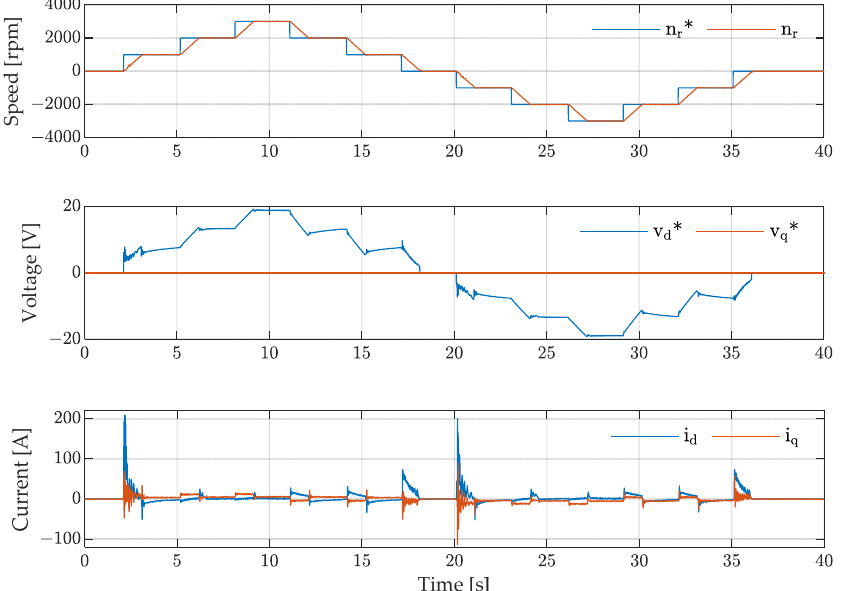
Figure 26. Speed profile up to nominal reference speed with no ‐ load and required power factor of 0.95: speed, dq voltages, dq currents.